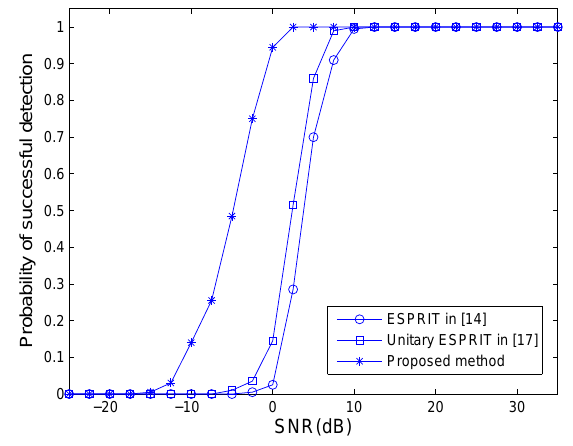
Figure 3. Probability of successful detection versus